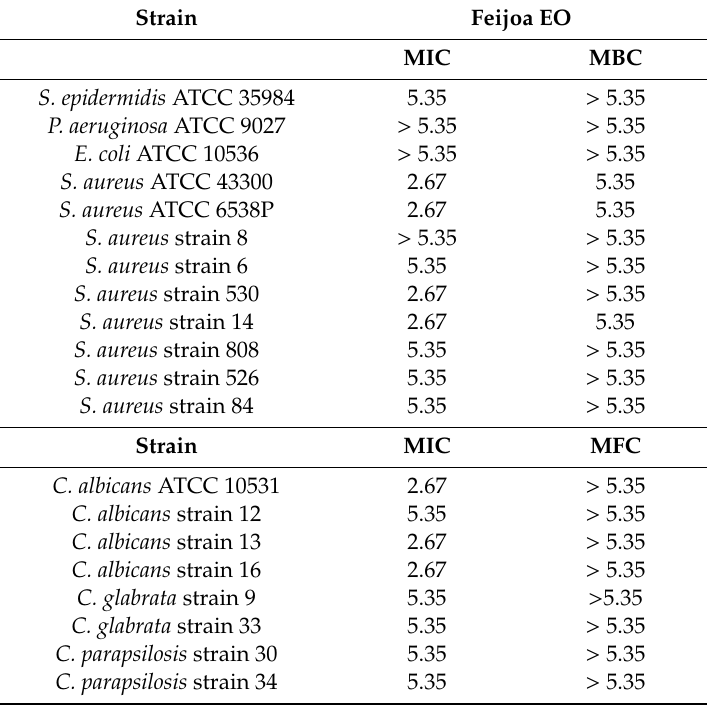
Table 2. Minimum inhibitory concentrations (MIC), minimum bactericidal concentrations (MBC), and minimum fungicidal concentrations (MFC) values (mg / mL) of feijoa essential oil against bacterial and fungal